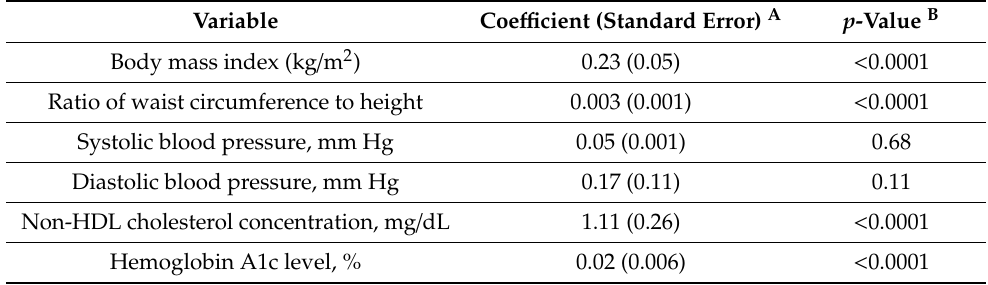
Table 3. Cardiometabolic risk factors by continuous subsidy score, obtained from the National Health and Nutrition Examination Survey from 2009–2014.